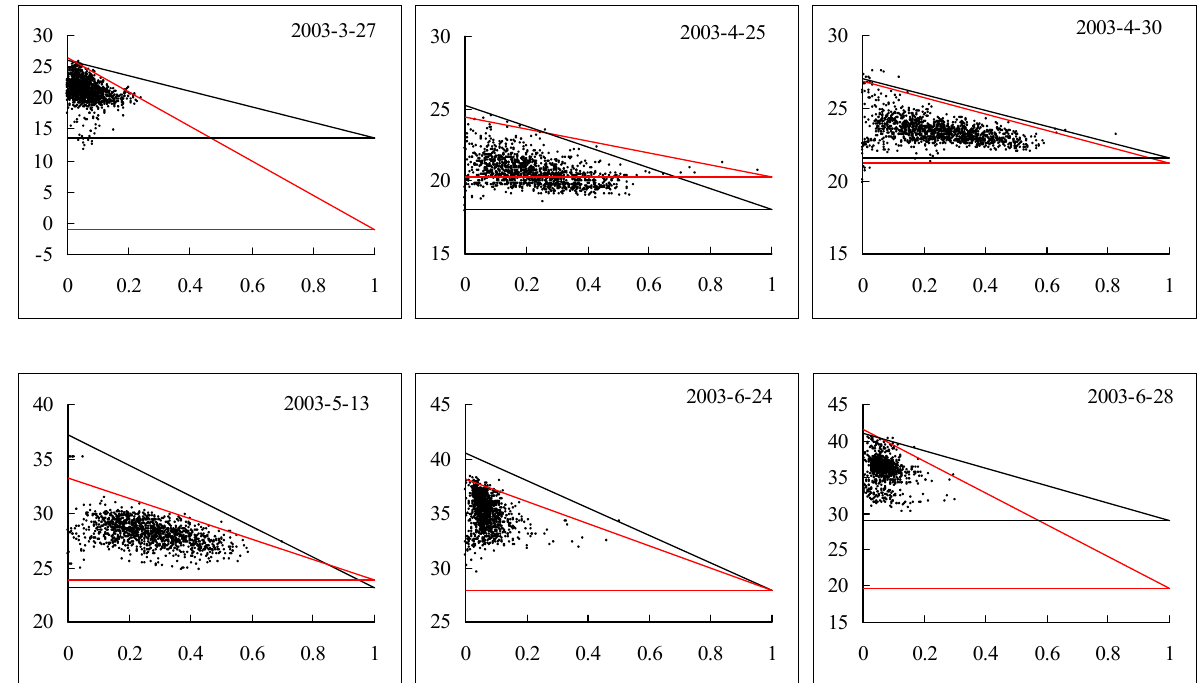
Figure 9. The VI-Ts diagrams defined by the proposed (black) and traditional (red) methods using MODIS data across 2003. The horizontal axis is vegetation cover fraction, and the vertical axis is surface temperature in